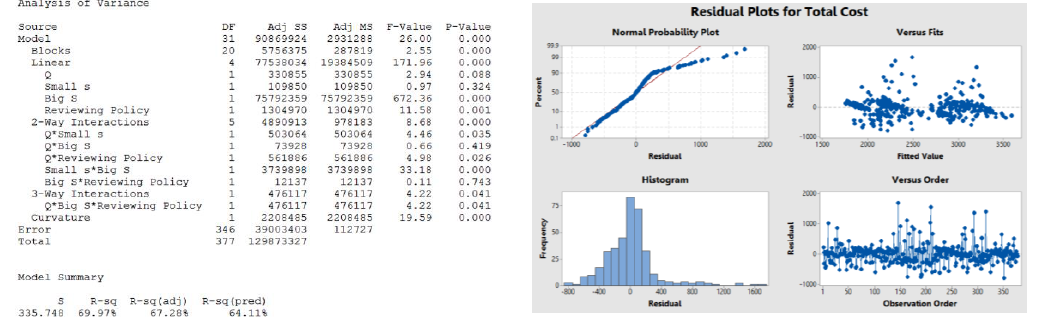
Figure 10. Analysis of variance and residual plot of full factorial design.